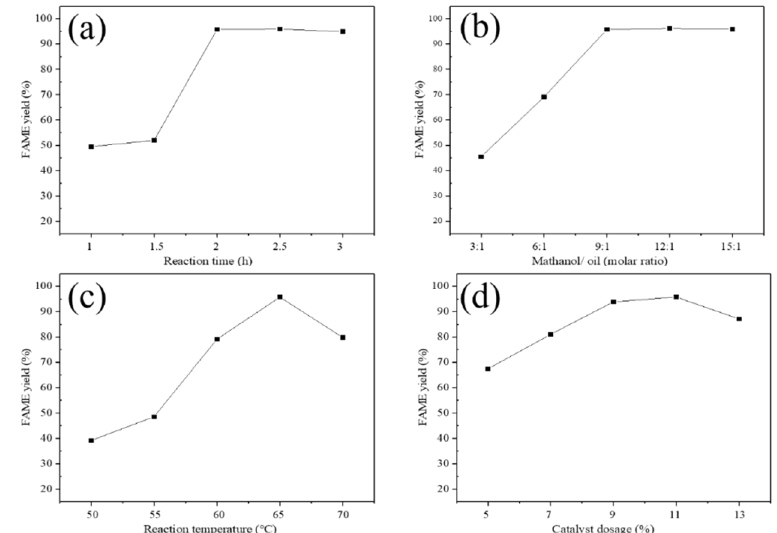
ff ect of the di ff erent operating parameters; ( a ) E ff ect of the reaction time (reaction Figure 8. Effect of the different operating parameters; ( a ) Effect of the reaction time (reaction Figure 8. E